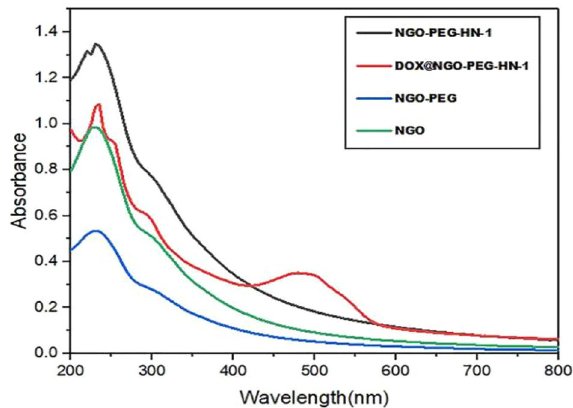
Figure 1. The UV–Vis spectra of NGO, NGO-PEG, NGO-PEG-HN-1 and DOX@NGO-PEG-HN-1.